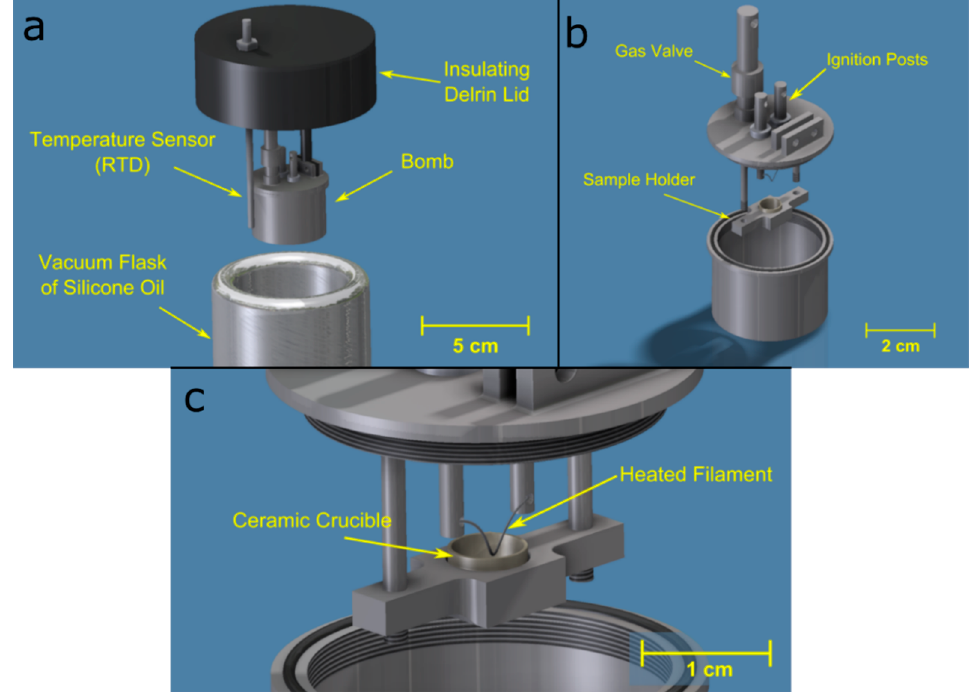
Figure 3. ( a ) Major components of the Ti particle bomb calorimeter assembly, including a vacuum flask of silicone oil, an resistance temperature detector (RTD), and a Delrin lid for insulation. ( b ) The environment of the bomb is controlled via the gas valve welded to the lid, and ignition is achieved by connecting leads from the power supply to the ignition posts. ( c ) Particle samples are contained in a ceramic crucible that is raised until the sample is in contact with a filament that is resistively heated for ignition.